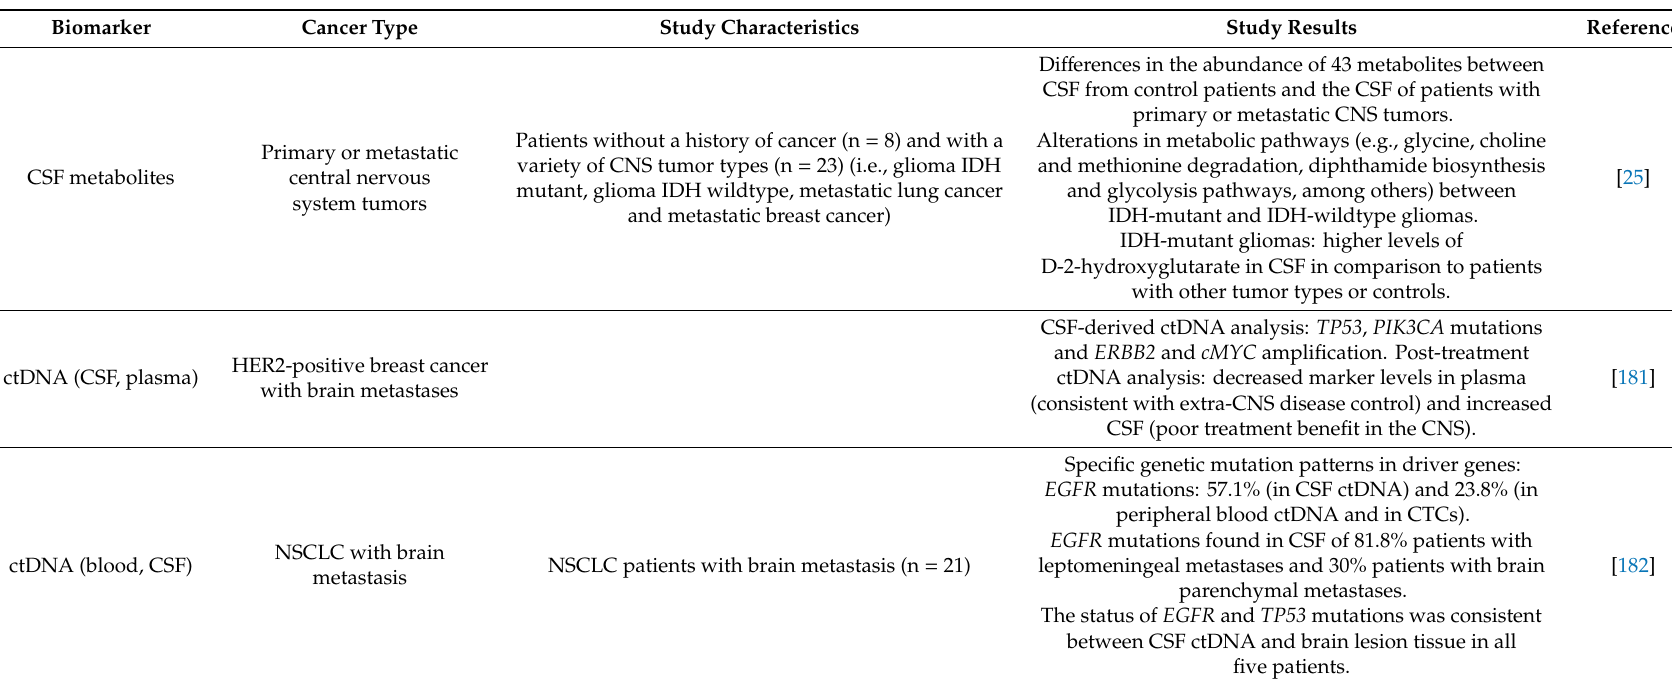
Table 5. The mutation patterns or metabolites di ff erences as potential cancer biomarkers applied in CSF-based liquid